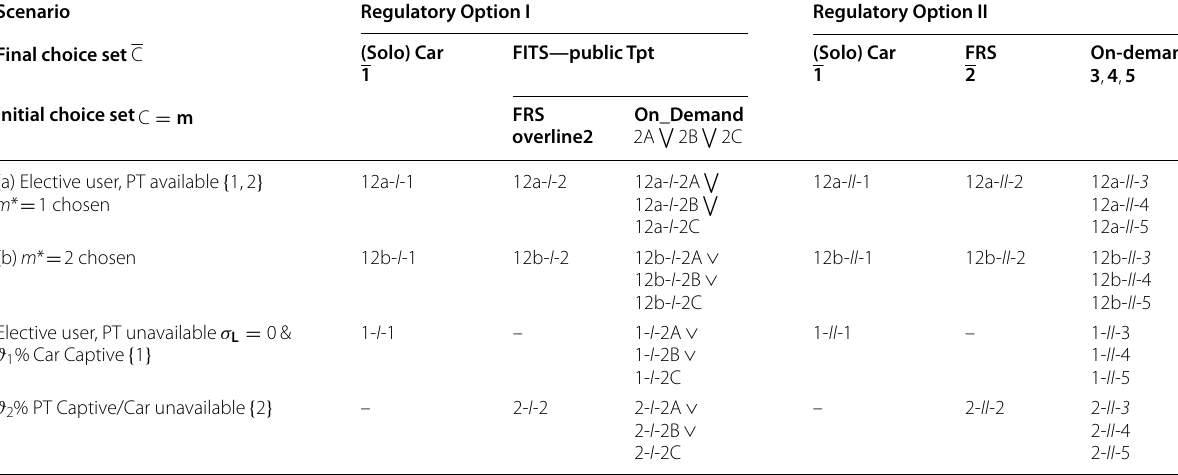
18 possible transitions ×